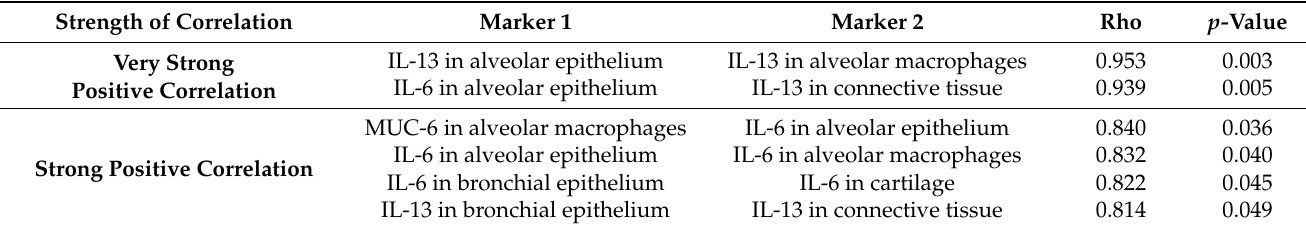
Table 6. Spearman’s rank correlation coefficient revealed correlations between the relative numbers of different factors in the stratified squamous epithelium